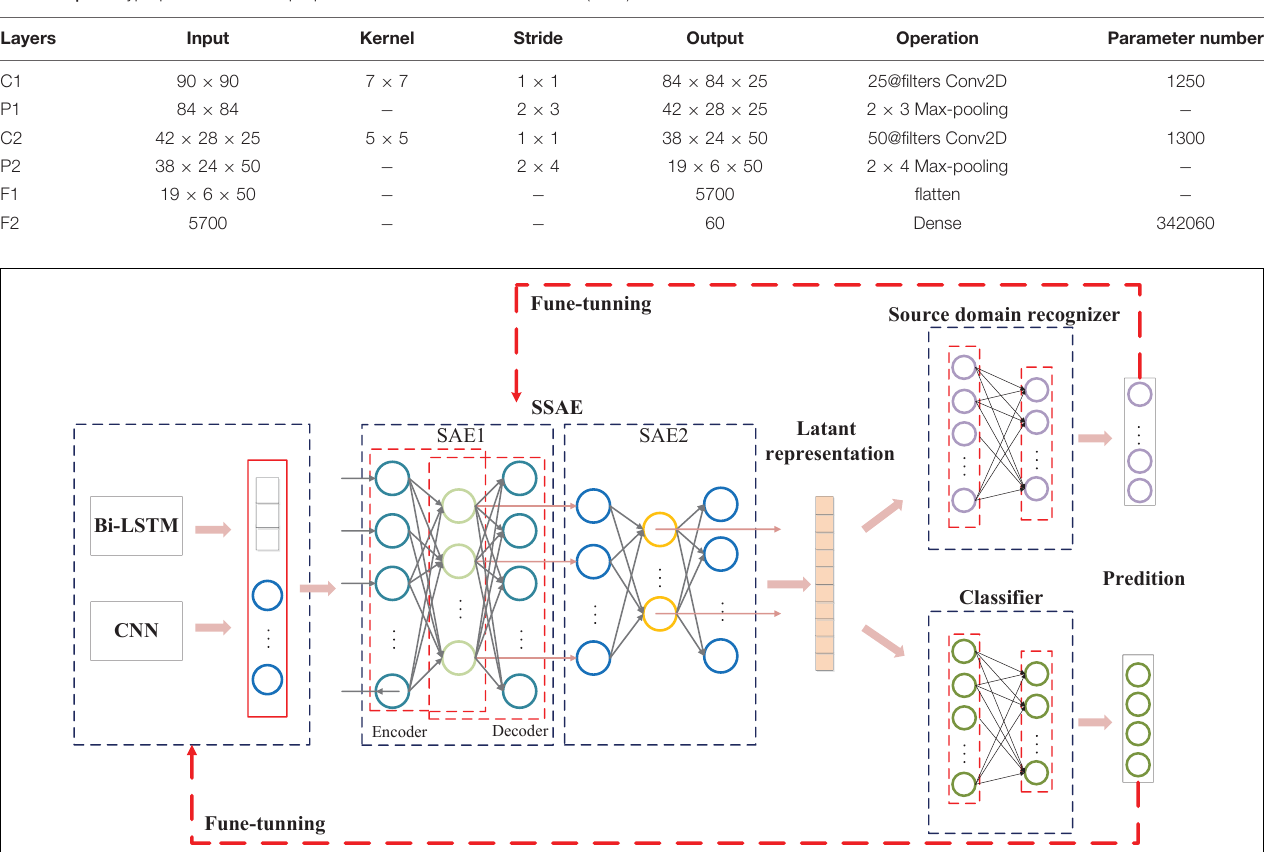
TABLE 2 | The hyperparameter of the proposed convolutional neural network (CNN).